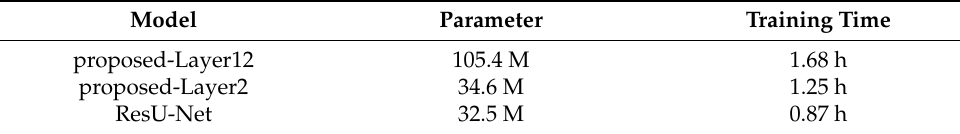
Table 6. The comparison of models on time consumption and parameters.